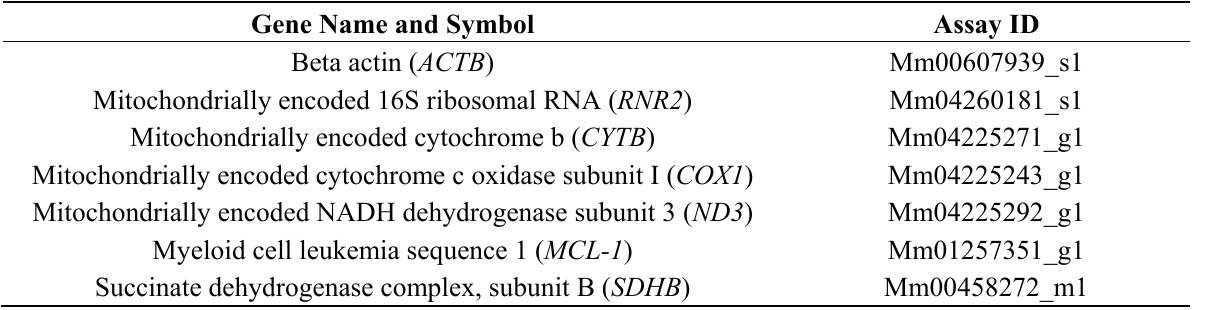
Table 1. TaqMan probes used for RT-PCR gene expression